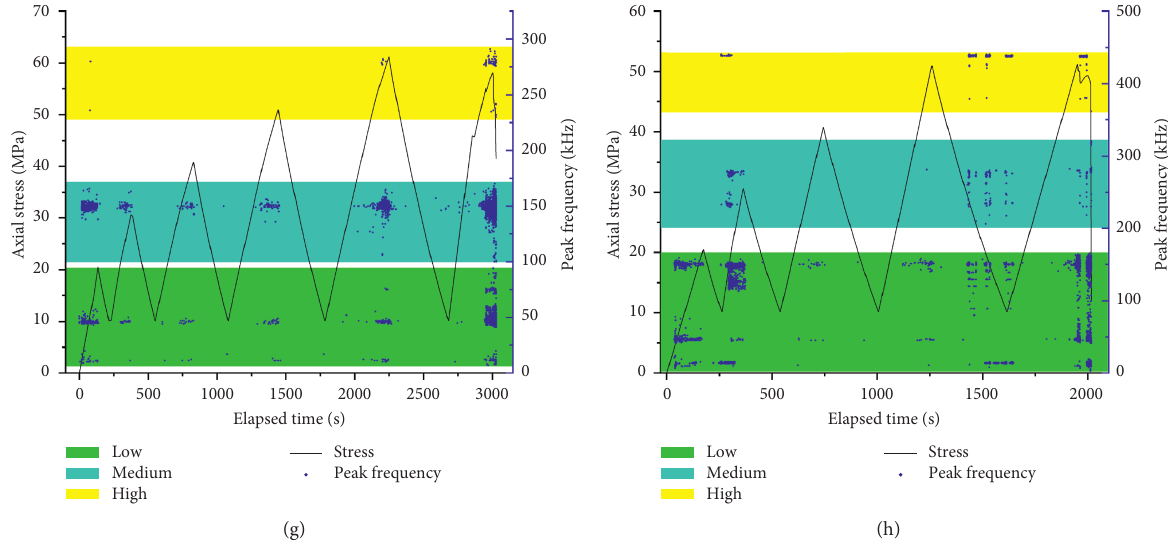
Figure 12: AE peak frequency with time curves of tuff specimens under different stress paths: (a) NF1; (b) FT1-3; (c) NF2; (d) FT2; (e) NF3; (f) FT3; (g) NF4; (h) FT4.